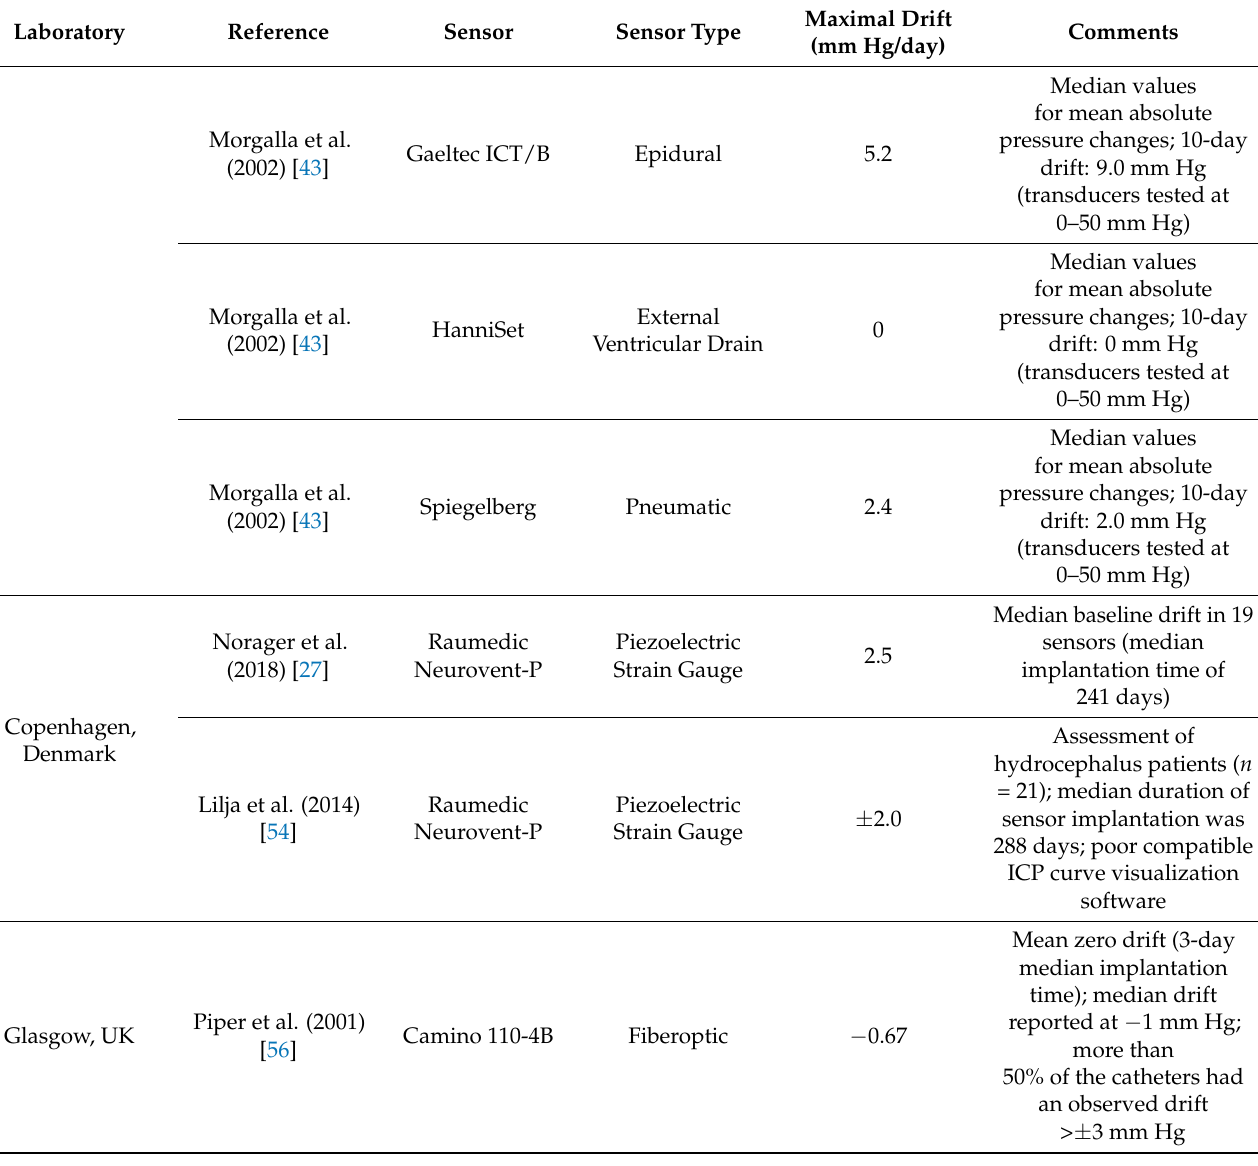
Table A2 highlights the main differences in measurement capacity found between